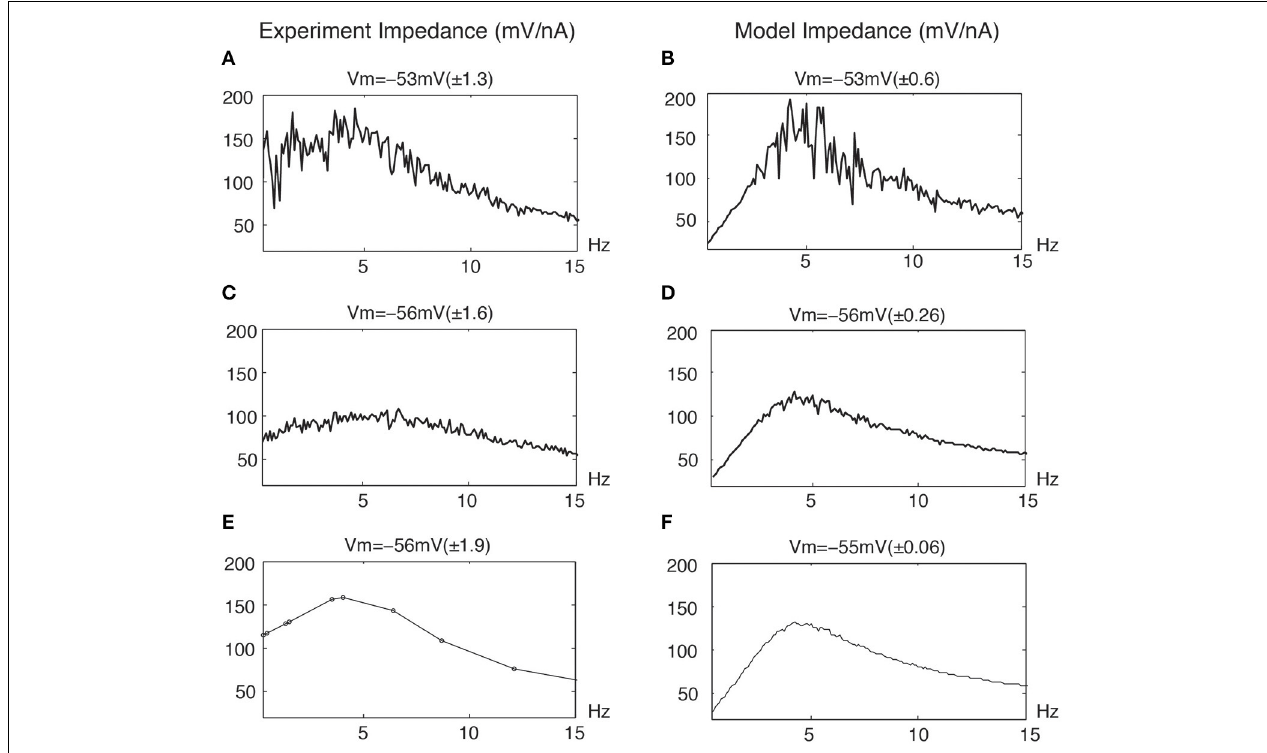
FIGURE 5 | Distortion of linear impedance (mV/nA) by the stimulation profiles for experimental data and model simulations. The average membranepotential V m isgivenalongwithSTDvaluesofmembranepotential. The standard deviations are given in parenthesis. (A,C) Experimental data : the